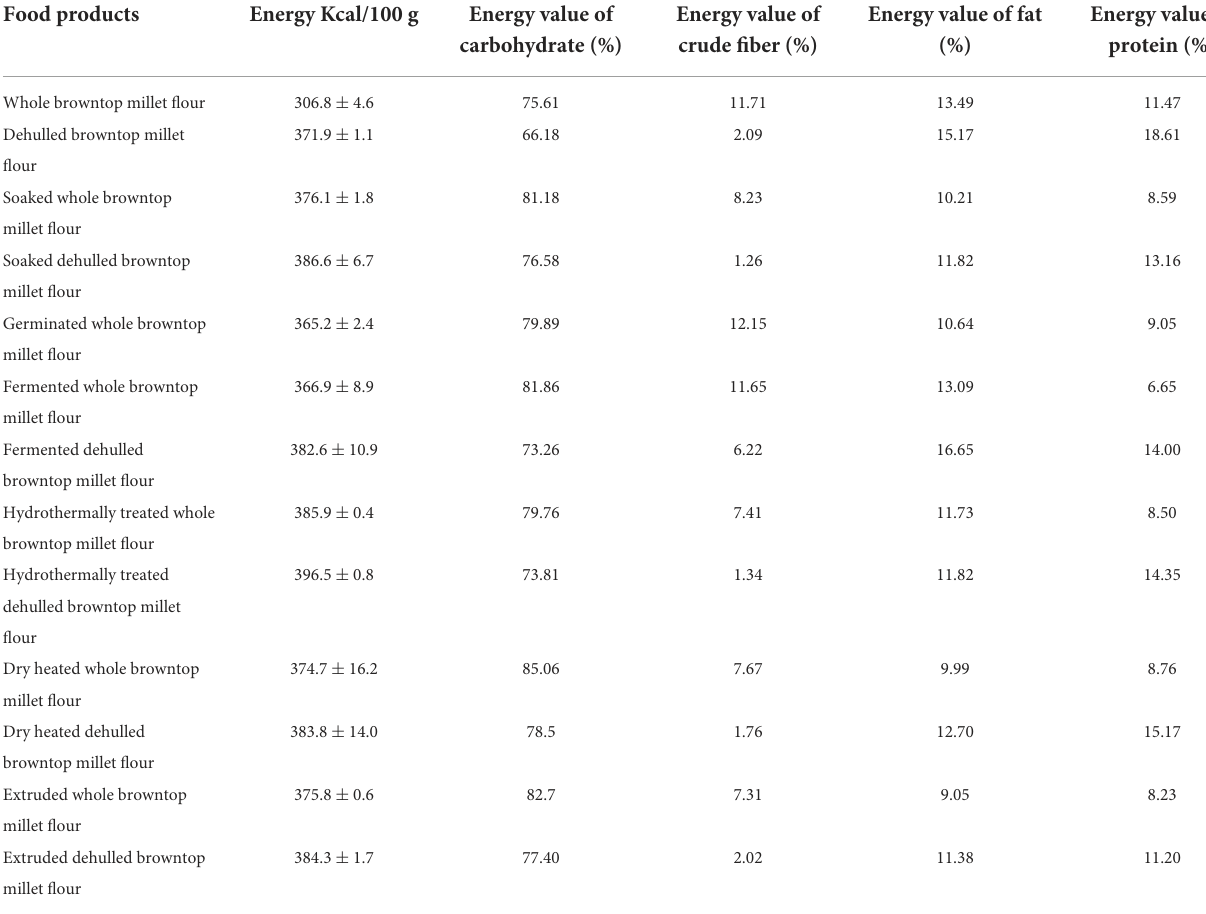
TABLE 5 Percentage of energy value of macronutrients of differently processed food products of browntop millet. Food